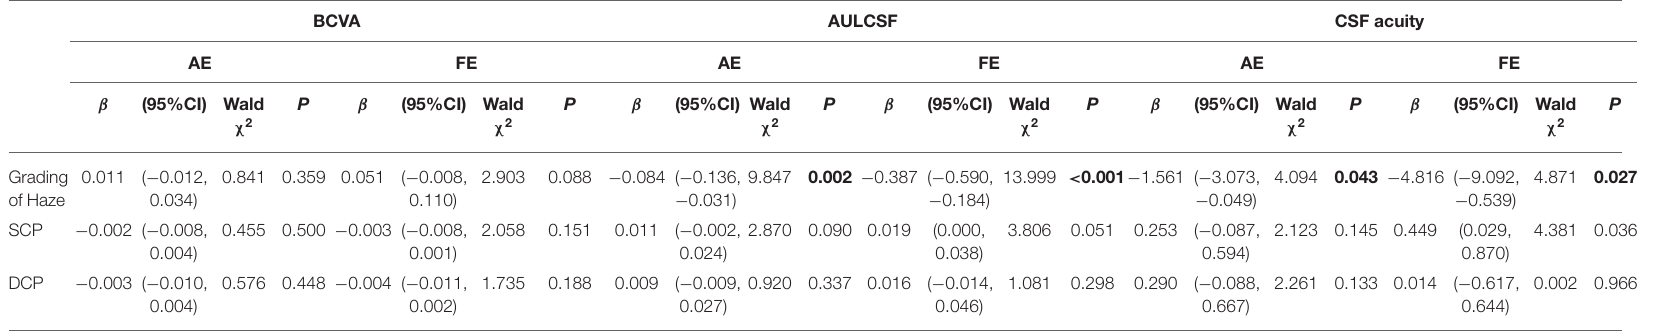
TABLE 3 | Visual function–ocular structure correlation of FUS eyes. BCVA AULCSF CSF acuity